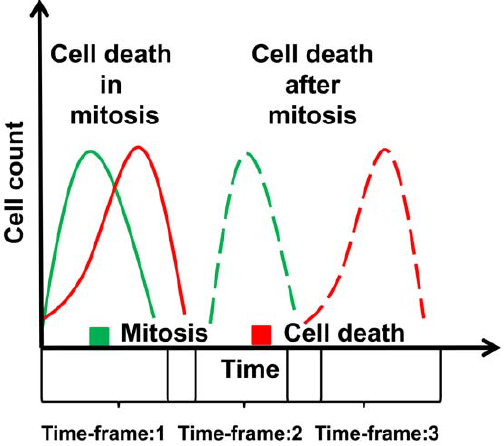
Figure 4. Time series of interphase cells during five days of screening. The population shows a periodicity of , 35 hours representing the cell cycle duration (blue bars: interphase counts (normalized by B-Score normalization) of all screened cells for each time-frame, red curve: fitting curve).